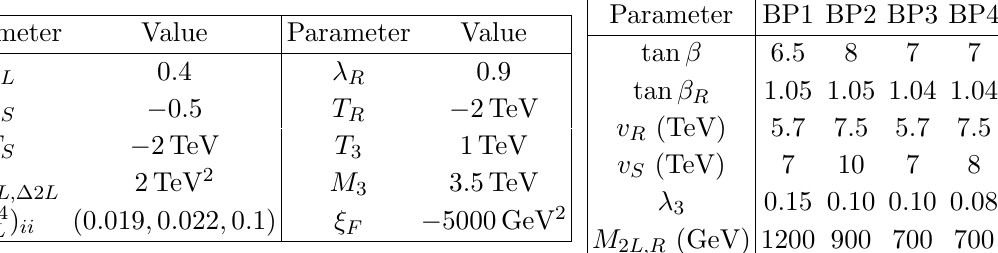
Table 1 . Benchmark scenario de(cid:12)nitions. Parameter values common to all benchmark points are shown in the left panel, while benchmark-speci(cid:12)c choices are shown in the right panel. We moreover set (cid:21) 4 = (cid:21) 5 = T L = T 4 = T 5 = 0 for